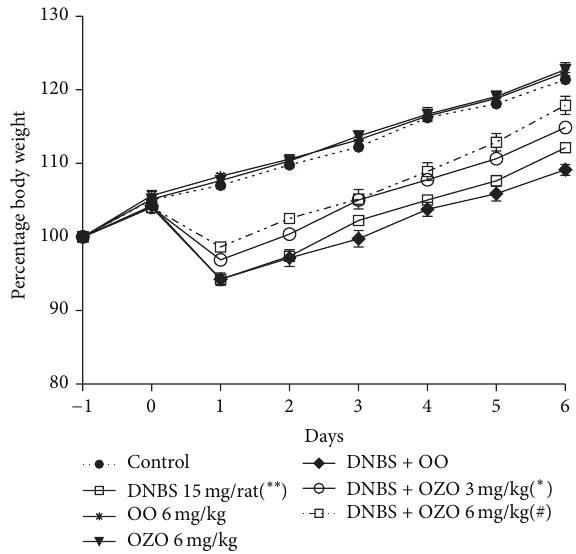
Figure 1: Body weight change in the different experimental groups. Data are expressed as mean values ± SEM. 𝑛 = 6 rats per group. Statistical analysis was performed with Two-Way ANOVA; ∗ and # 𝑃 valuesarelessthan0.05and0.01,respectivelyversusinflamedgroup; ∗∗ 𝑃 < 0.01 versus control group.